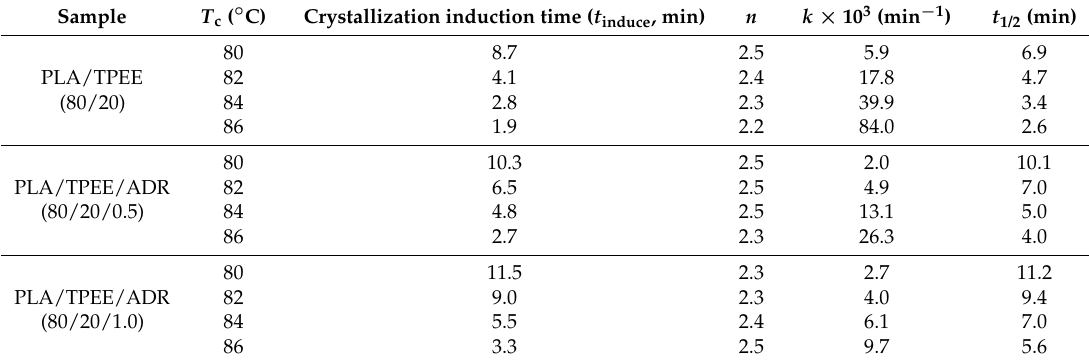
Table 1. Data of isothermal cold crystallization kinetics for PLA/TPEE/ADR blends.